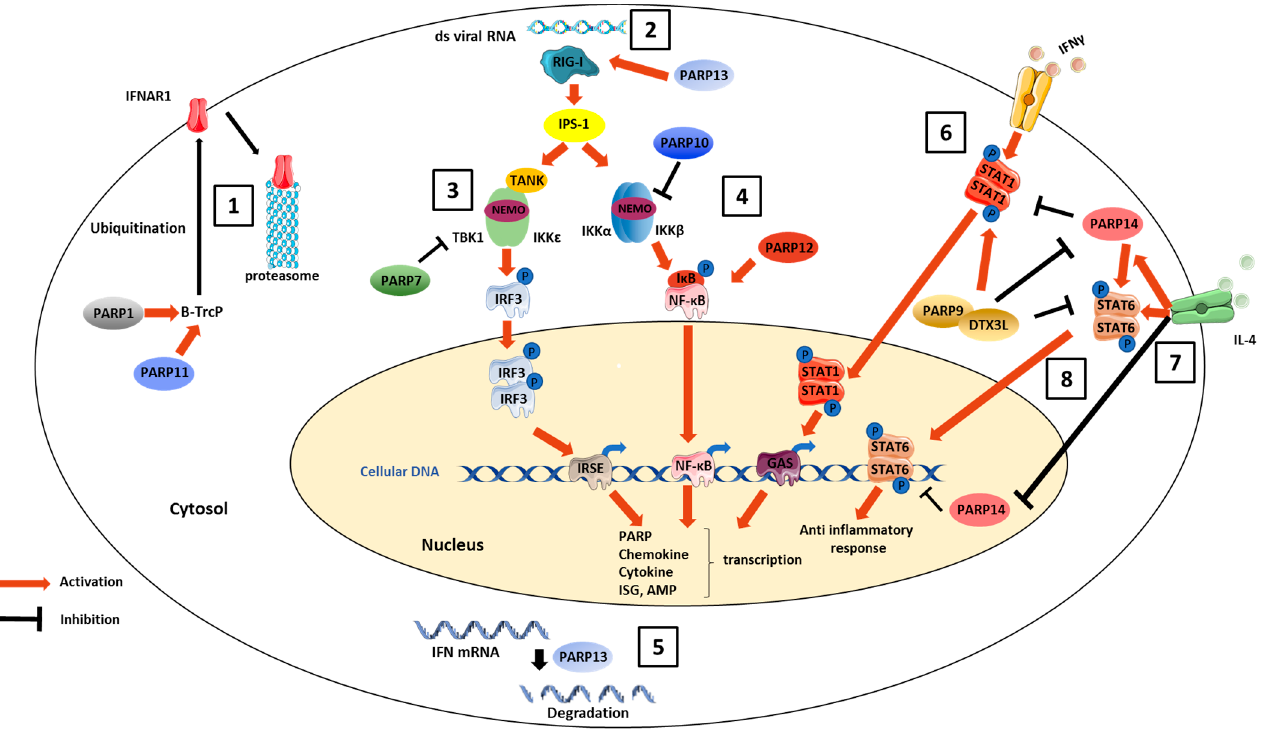
Figure 2. Indirect antiviral activities of PARPs through immunomodulation. PARP1 and PARP11-induced MARylation of the β -transducin repeat-containing protein ( β -TrCP), an E3 ubiquitin ligase, promotes interferon alpha/beta receptor 1 (IFNAR1) ubiquitination and degradation ( 1 ). Concerning RNA virus sensing pathways, PARP13 overexpression en- hances oligomerization of retinoic acid-inducible gene I (RIG-I) ( 2 ), which leads to robust activation of downstream anti- viral signaling through the interferon regulatory factor 3 (IRF3) pathway. On the other hand, PARPs can also downregu-